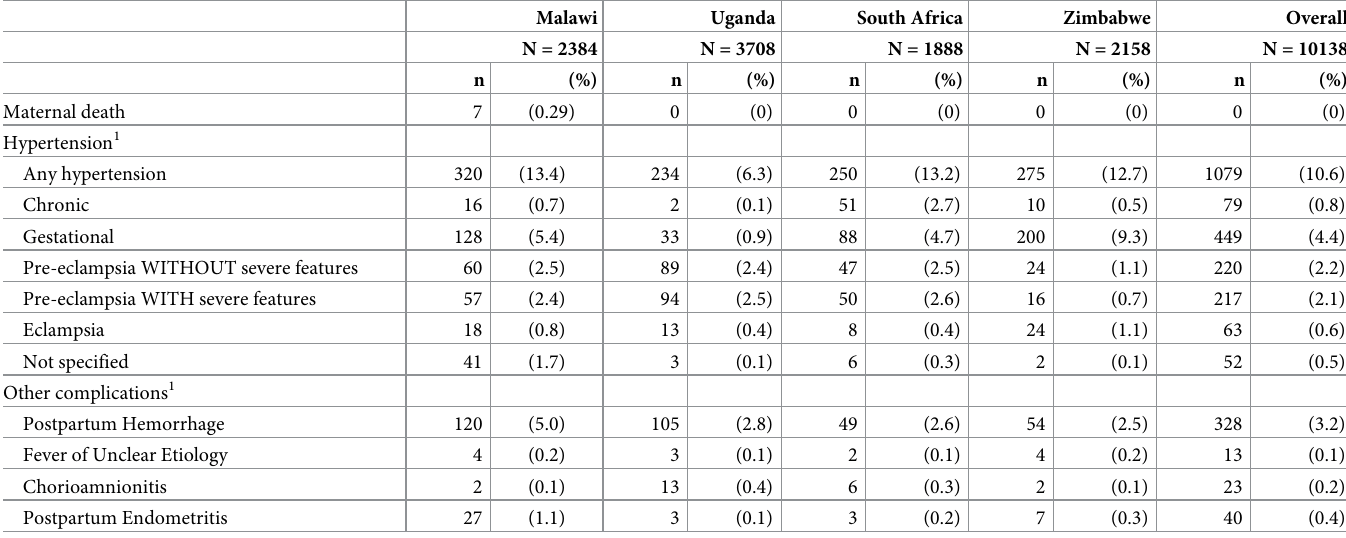
Table 6. Frequency of maternal deaths and pregnancy complications.